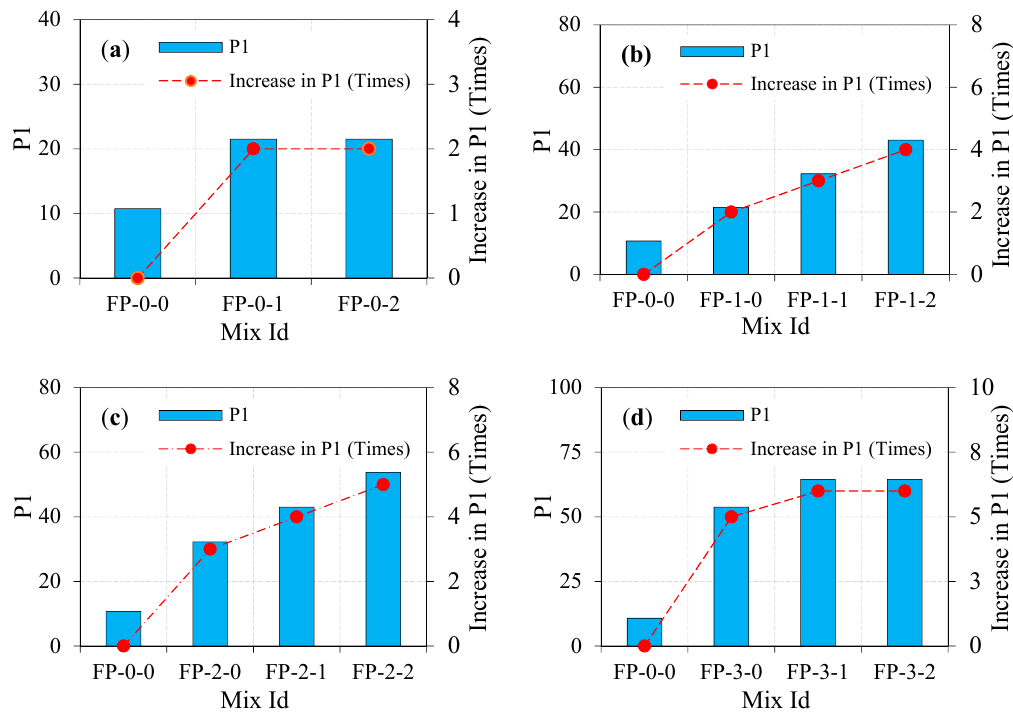
Figure 9. Number of impacts needed to induce crack commencement. ( a ) zero layer mesh; ( b ) one layer mesh; ( c ) two layer mesh and ( d ) three layer mesh